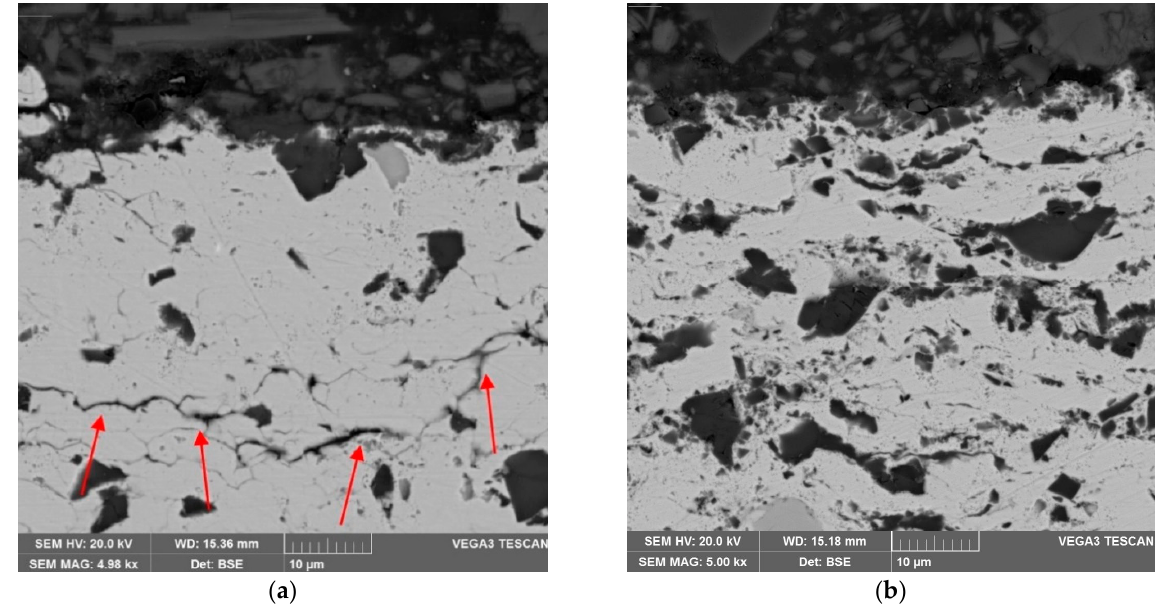
Figure 7. SEM (BSE) micrographs of the top part of the ECu/2/F ( a ) and OCu/2/F ( b ) coatings. Red arrows mark the damaged region by spraying an additional layer of SiC.